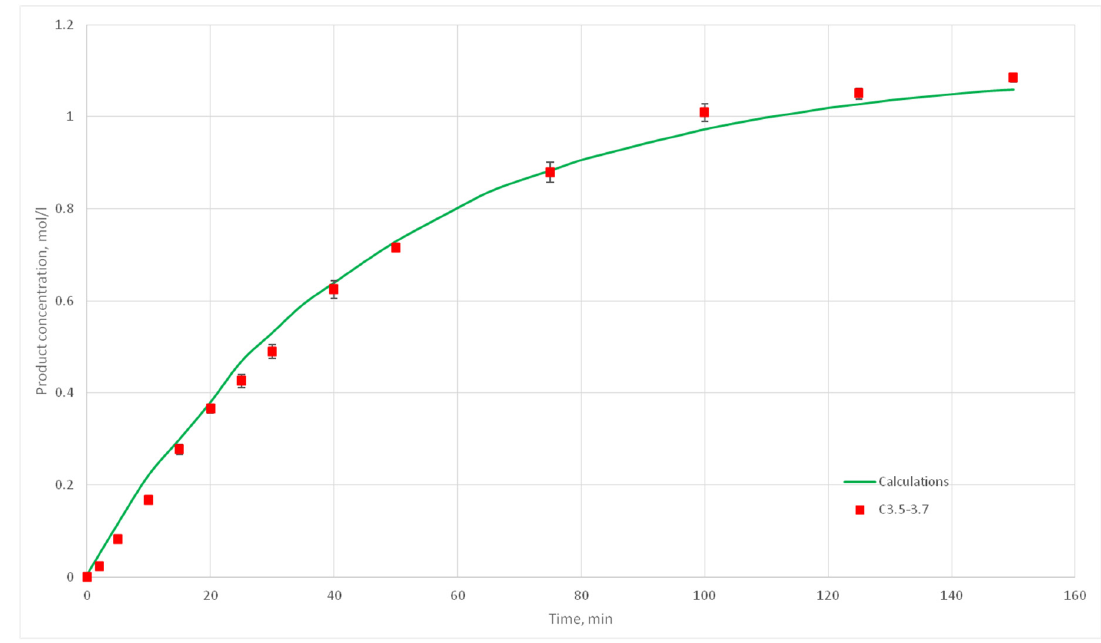
Figure 23. Calculation and experimental reaction kinetic curves for С 3.5, 3.6 и 3.7 experiments.